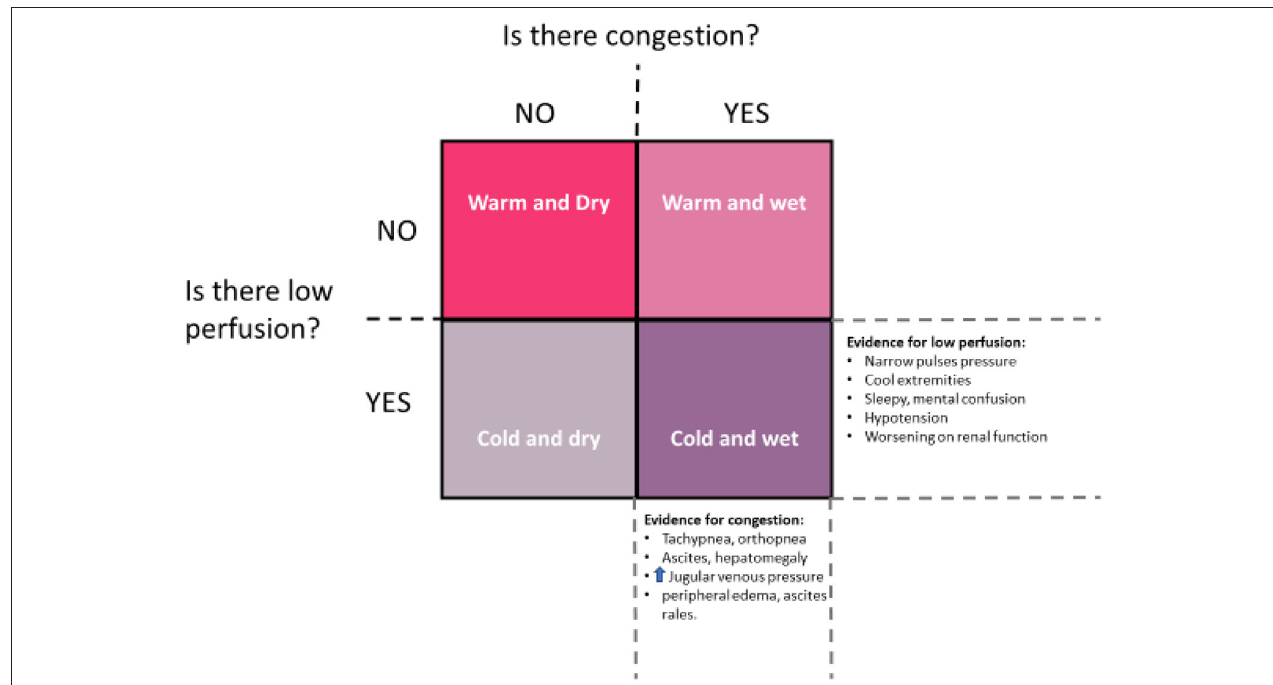
FIGURE 1 | Clinical assessment in ADHF should answer the two questions suggested by this diagram: First, does the patient present with significant congestion? Second, does the patient present with significant underperfusion? Using this construct, patients will segregate into one of four categories in accordance with clinical findings. Typically, patients move in a clockwise fashion through these categories, first becoming congested (warm and wet) and then vasoconstricted to maintain blood pressure (cold and wet). Once vasoactive support and diuresis is achieved, movement is generally counter-clockwise, from cold and wet, to warm and wet, and then warm and dry. However, some patients will remain underperfused despite restoration of normovolemia, representing the cold and dry group, for whom mechanical support may be needed [image redrawn from Kantor and Mertens ( 13)].